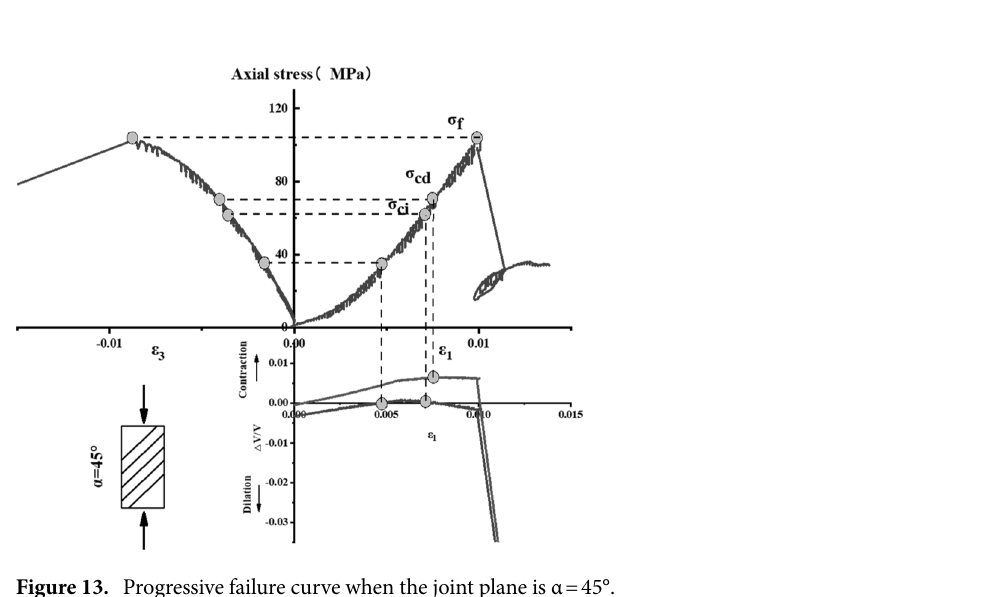
Figure 12. Progressive failure curve when the joint plane is α = 30°.